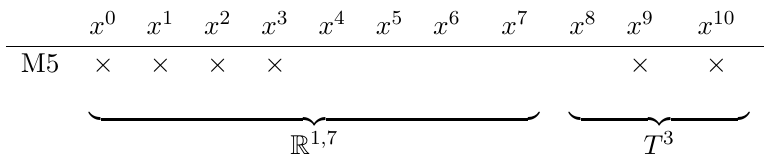
Figure 1 . Beginning with a D4 -brane (red) in Type IIA wrapped on R 1 , 3 × S 1 S 1 to obtain a D3 -brane (blue) in Type IIB on R 1 , 3 . Performing a second T-duality on S 1 9 D4 -brane on R 1 , 3 × S 1 , which upon interchange S 1 8